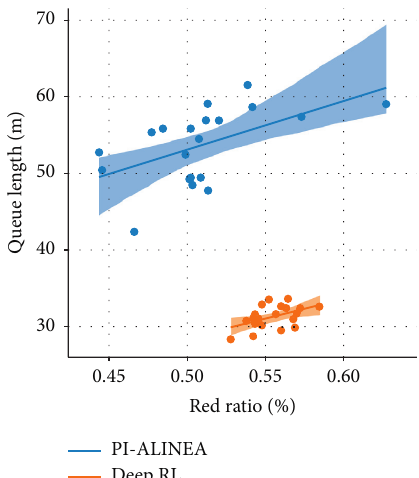
Figure 12: Relationship of queue length and red ratio for (a) PI-ALINEA and (b) DRL.